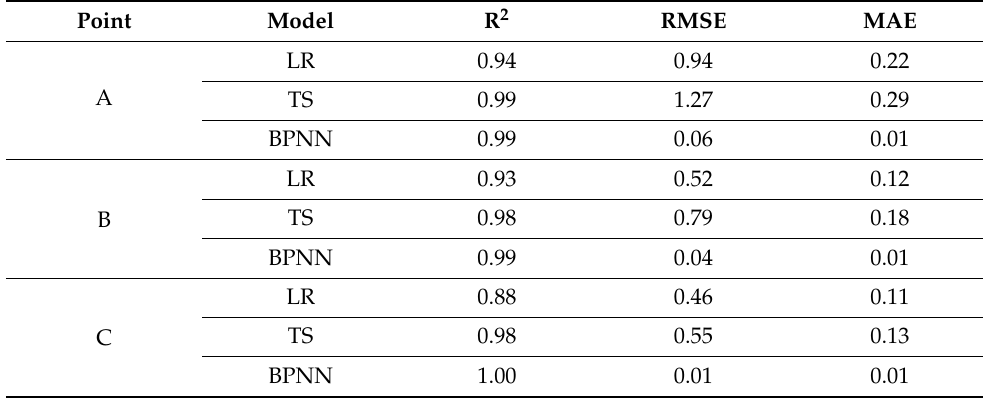
Table 2. Results comparison between different